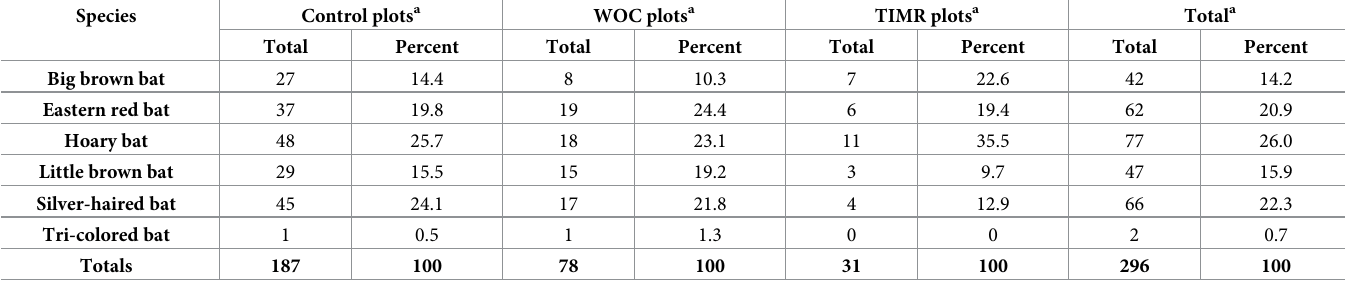
a Data were collected at plots for 10 control turbines, 10 wind speed-only curtailed (WOC) turbines with a cut-in speed of 4.5 meters per second, and 10 Turbine Integrated Mortality Reduction (TIMR) system-curtailed